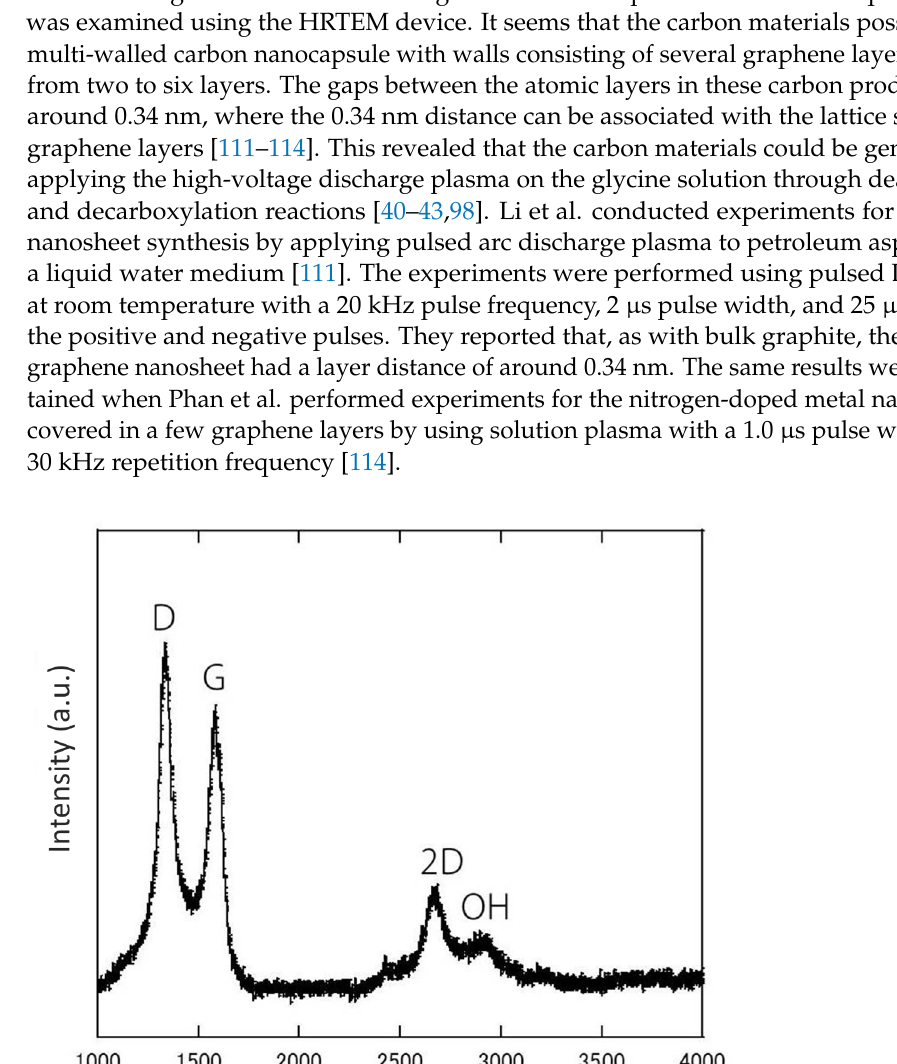
Figure 11. SEM images of the carbon material products formed from various amino acid com- pounds, with their photographs in the insets [41].